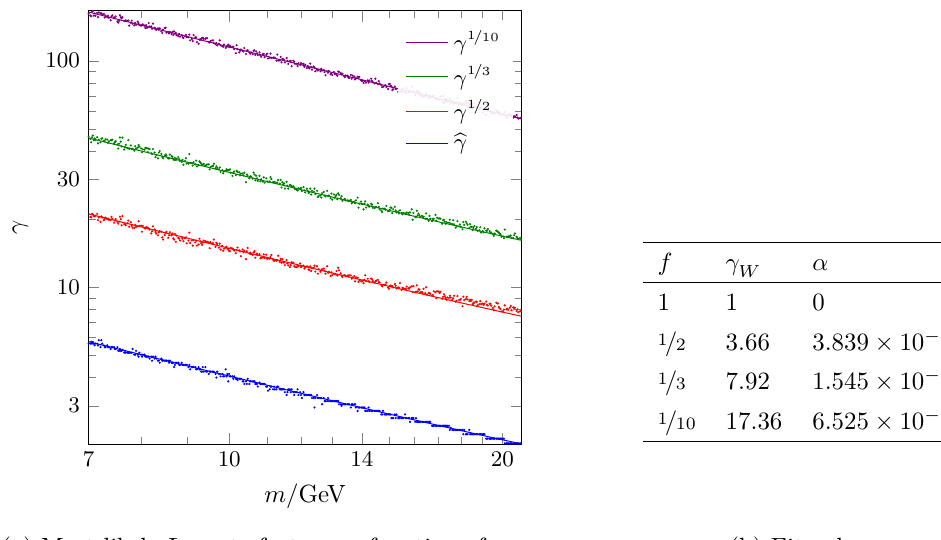
Figure 12 . Panel (a): most likely Lorentz factors b γ of heavy neutrinos as a function of their masses. The points correspond to MC data and the lines to a fit. Panel (b): fit parameter of the function ( 6 . 2 ) for the most likely Lorentz factors b γ after applying a threshold f